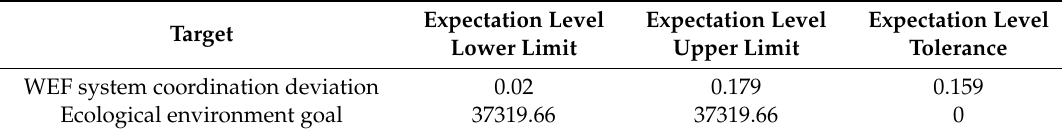
Table 1. Optimization Model Target Expectation Level of WEF System Security in Ordos.